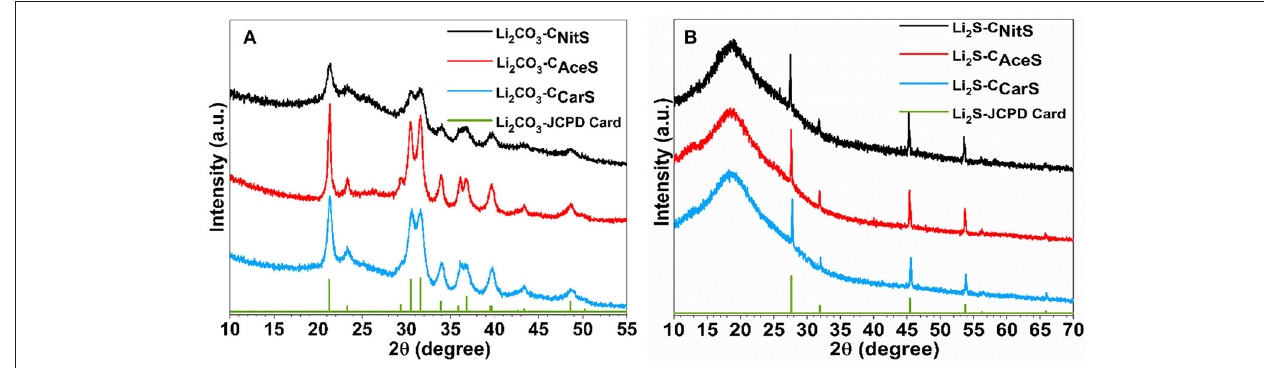
FIGURE 1 | XRD patterns of (A) the Li 2 CO 3 -C composites obtained from ASP and (B) the Li 2 S-C composites after sulfurization.